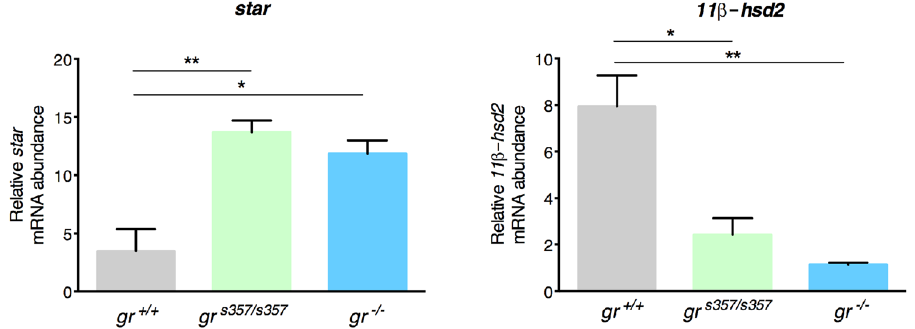
Figure 5. Expression of star and 11 β - hsd type 2 genes supports cortisol synthesis in gr mutant lines. qRT-PCR analysis of star and 11 β - hsd type 2 in gr + / + , gr s357 / s357 and gr − / − 5-dpf zebrafish larvae deriving from homozygous parents under basal conditions. Values represent the mean ± SEM. Asterisks indicate that expression levels are significantly different from the control (one-way ANOVA; * P < 0.05, ** P < 0.01). Data were generated from four biological replicates.